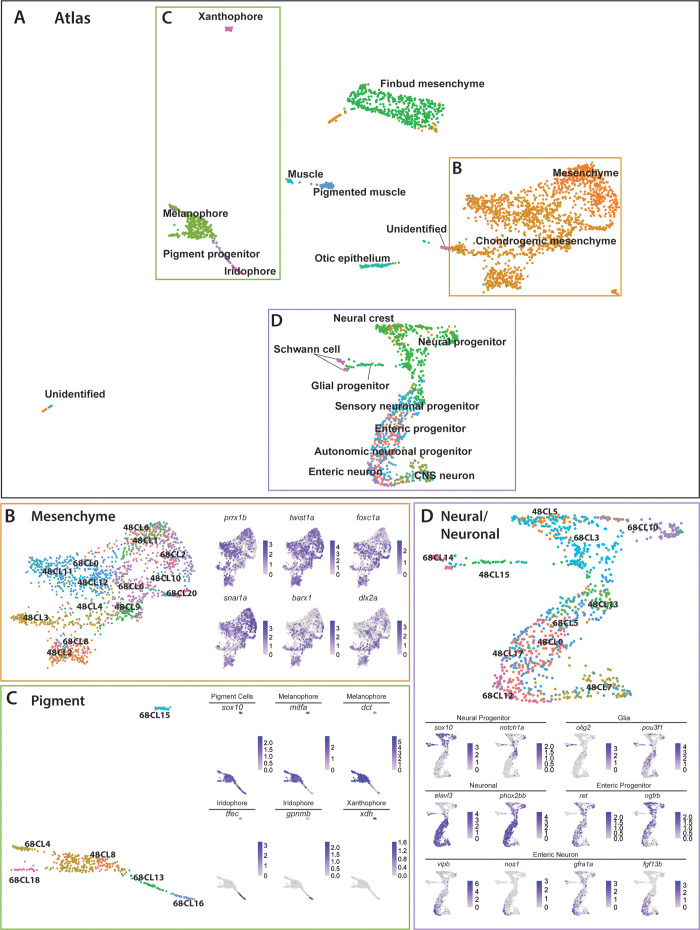
Integrated atlas of posterior sox10:GFP+ cell types spanning the embryonic to larval transition.(A) Global UMAP embedding demonstrating the clustering of cell types across 48–50 hpf and 68–70 hpf. Cell labels were transferred from the original curation (Figure 1—source data 2) to the new atlas after its creation, allowing for assessment of cell type organization. (B) Previously identified mesenchyme clusters form a large discernible cluster marked by prrx1b, twist1a, foxc1a, and snai1a, which was separated into both chondrogenic and general mesenchyme, as denoted by its differential expression of barx1 and dlx2a. Importantly, nearly every 48–50 hpf cell type nests with a cluster at 68–70 hpf. (C) Pigment cells clusters reflect differentiation paths described in Figure 4A. Melanophores at 48–50 hpf group near to the 68–70 hpf melanophore cluster, bipotent pigment progenitors bridges both the iridophores and melanophores. Xanthophores cluster separately, reflecting their distinct lineage of origin at this developmental window. (D) Detailed analysis of the larger neural/neuronal cluster shows clear progression of cell fates from progenitor to differentiating glia or neuron. The expression of enteric neuronal markers is distinct from other subtypes at this dataset.Figure 6—source data 1.List of marker genes per major cell type identity in the sox10:GFP+ merged atlas.Tables reporting the Seurat output for genes for each major cell type identity including p-values (<0.01), average log-fold change (≥0.25), adjusted p-values (≤1.0), pct.1 summarizing proportion of cells expressing the individual gene in the cluster identity category, pct.2 showing the proportion of cells expressing the individual gene in all cluster identity categories in the atlas dataset.